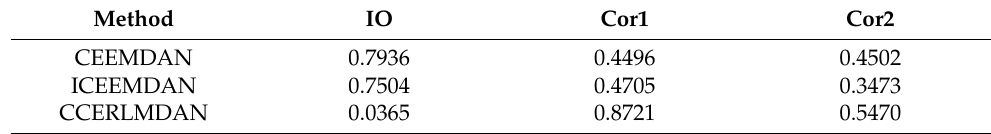
Table 1. The orthogonality and correlation coefficient of the three methods. Method